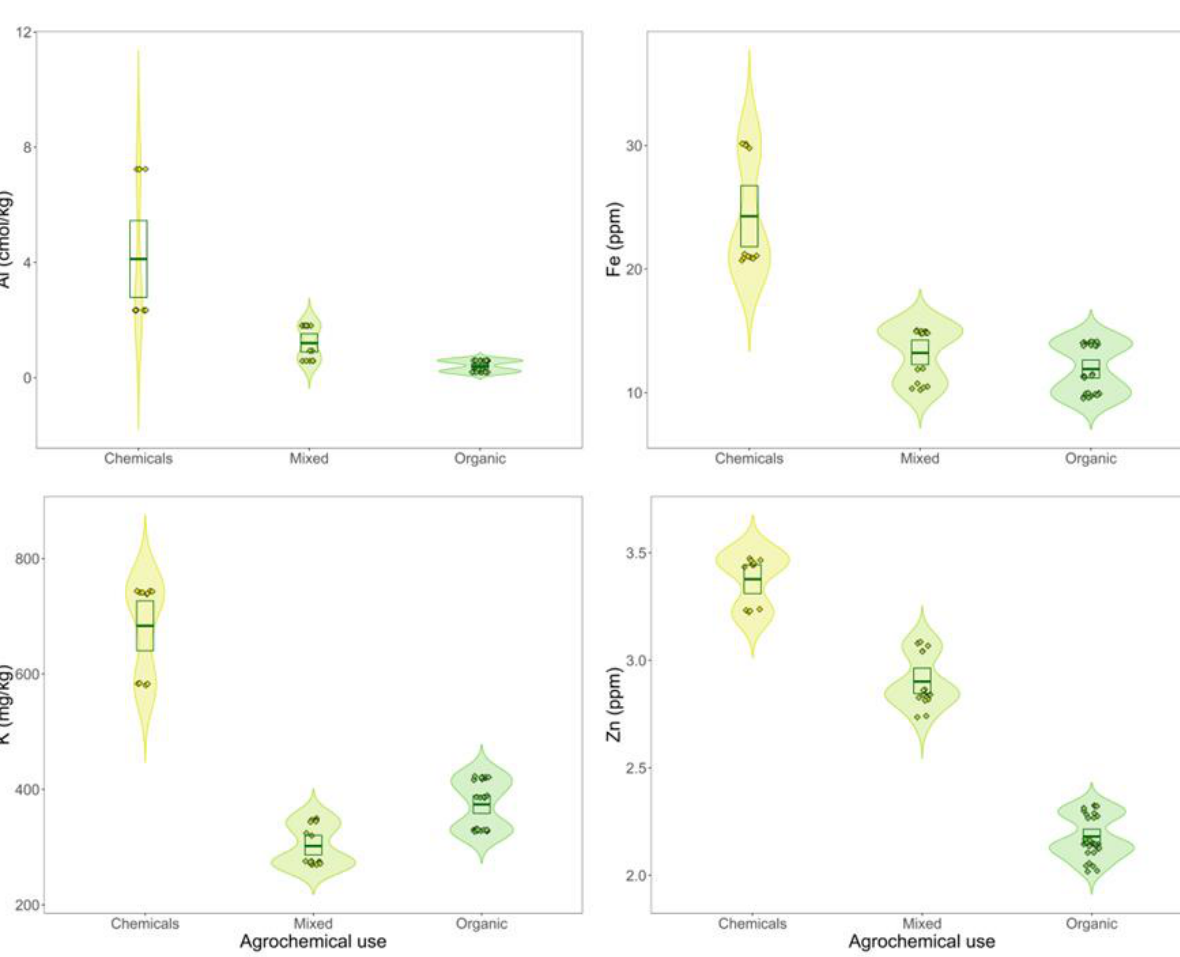
are pairwise ratios from estimated marginal means taken from generalised linear models.